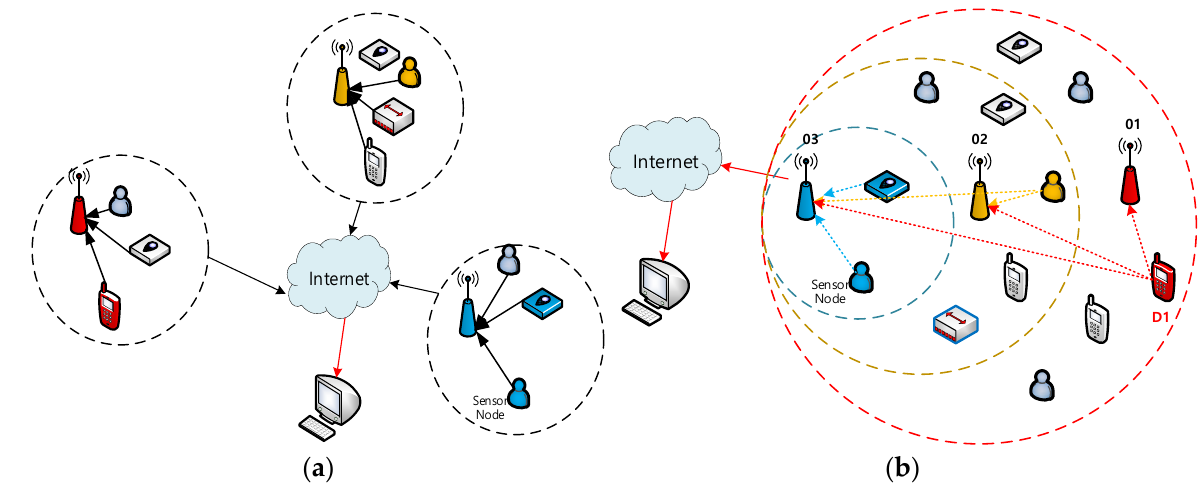
Figure 2. Networks for transmitting various types of data: ( a ) Network without priority data; ( b ) Network with priority data.